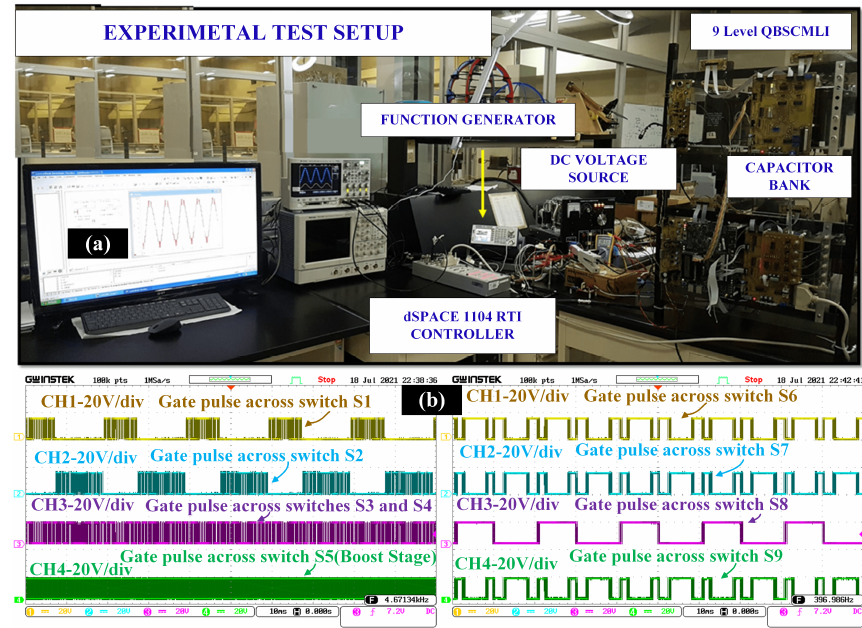
Figure 6. ( a ) Experimental Setup, ( b ) Gate pulses across switches S 1 to S 8